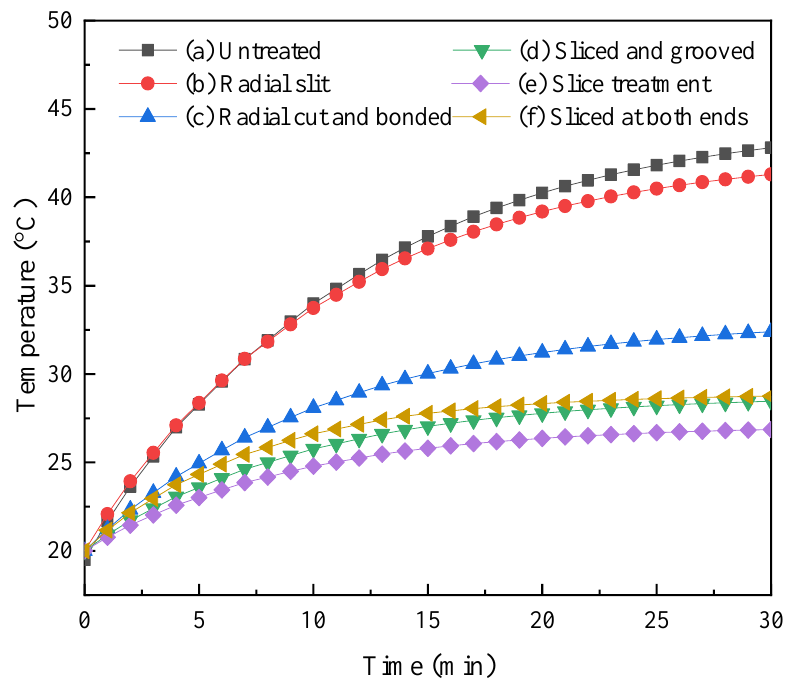
Figure 4. Temperature variation of Terfenol-D rods with time.